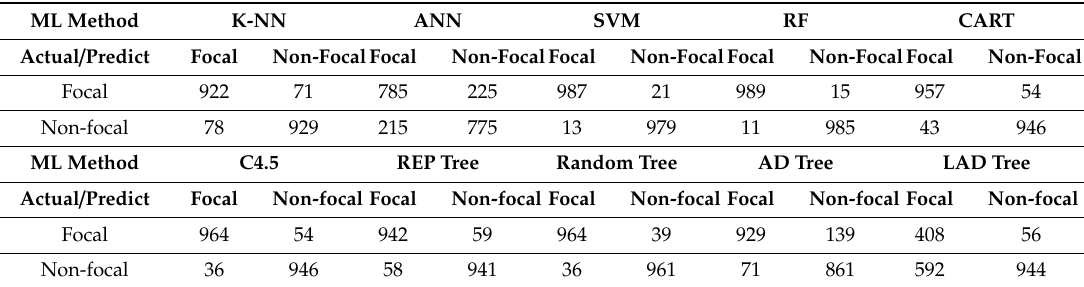
Table A1. Confusion matrix for Single Classifier.